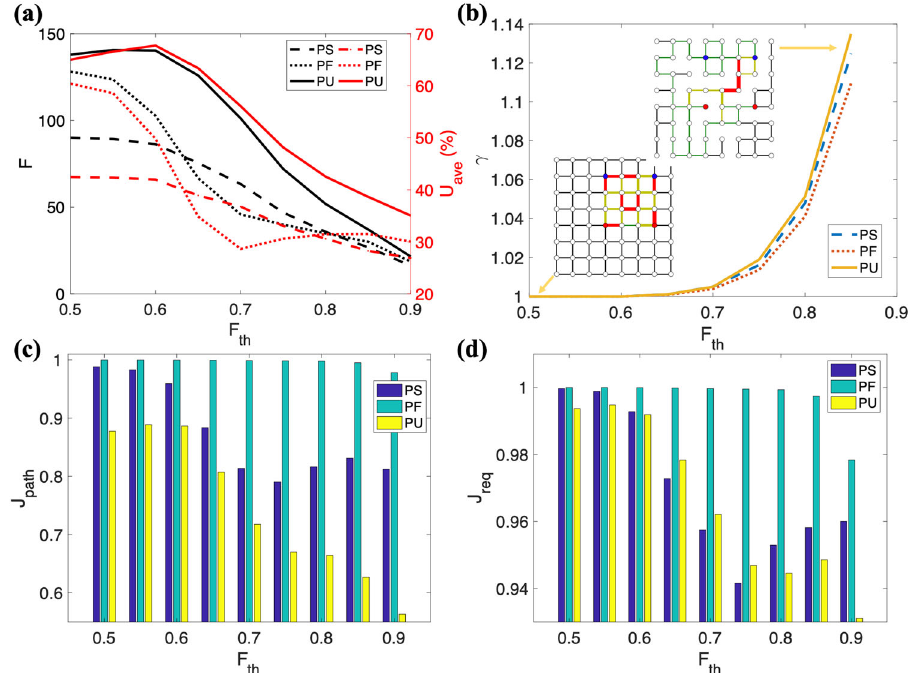
Fig. 6 Protocol performance with respect to fi delity threshold. a Total fl ow and average capacity utilization. Inset shows the minimum fl ow of the two requests. b Normalized path stretching factor. Traf fi c plots at two extreme case for the propagatory update algorithm are presented. c , d Fairness over paths ( c ) and requests ( d ). The fi delity distribution among edges follow the normal distribution N (0.8, 0.1) and the request distance is fi xed to be 3 here. The other system parameters are { l max , α , β } = {15, 1,